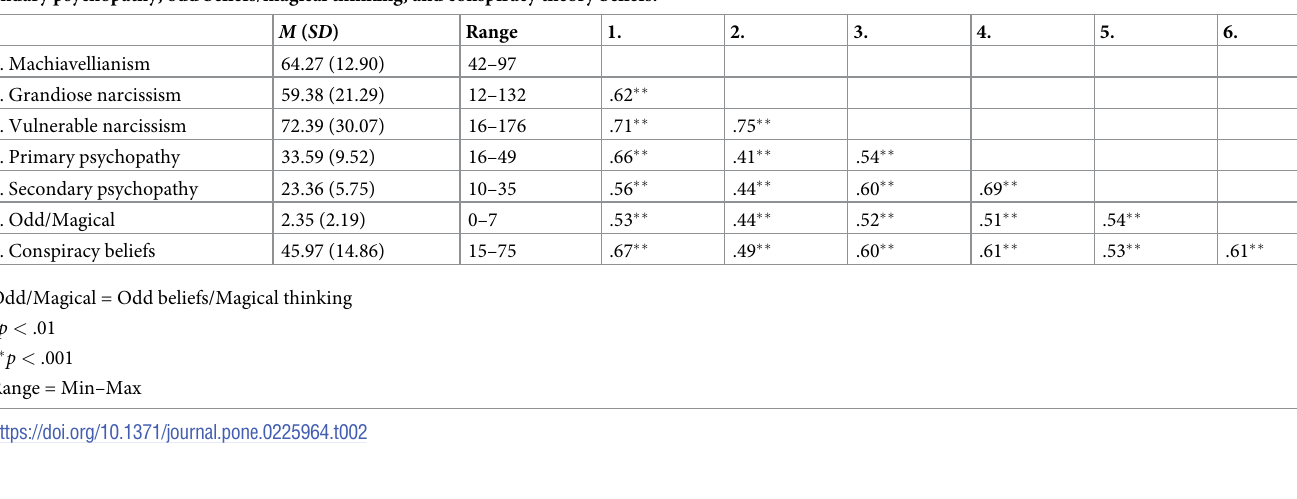
Table 2. Descriptive statistics and bivariate correlations for variables of Machiavellianism, grandiose narcissism, vulnerable narcissism, primary psychopathy, sec- ondary psychopathy, odd beliefs/magical thinking, and conspiracy theory